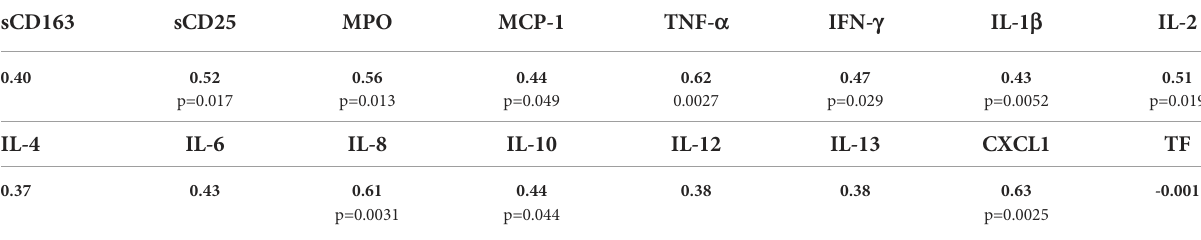
TABLE 3 Correlations between blood leukocyte count and levels of cell markers and cytokines in glioblastoma cyst fl uid. sCD163